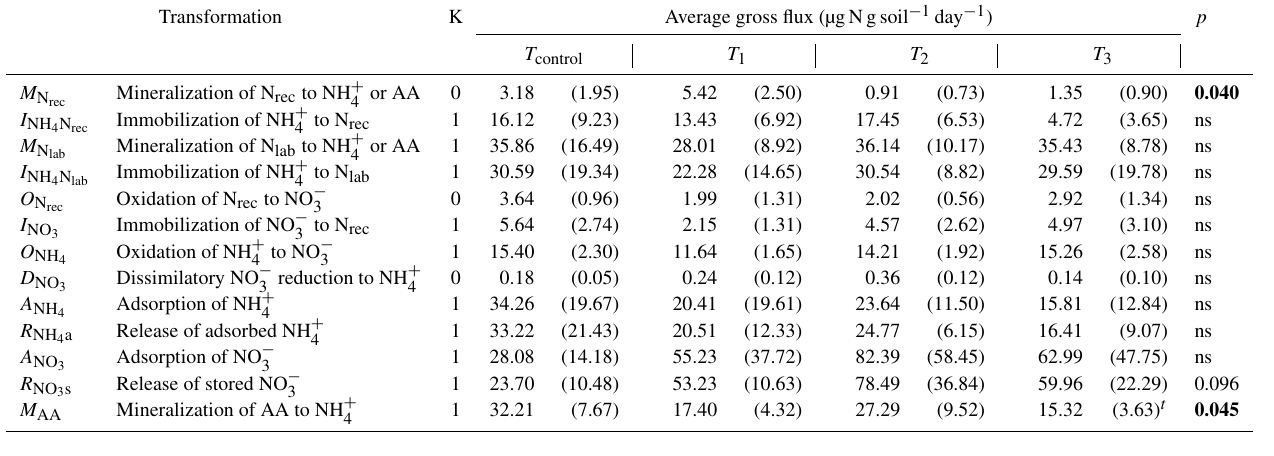
Table 1. Description of N transformations and average gross N fluxes per treatment (diagram shown in Fig. 2). Standard deviation in brackets. K stands for kinetics, where 0 implies the use of zero-order and 1 the use of first-order kinetics in the model. The p is the p value of the one-way ANOVA, with ns (non-significant) if p > 0.1 ( p value in bold if < 0.05). For the Holm–Šídák pairwise comparisons, t indicates a tendency to be different from control ( p < 0.10).